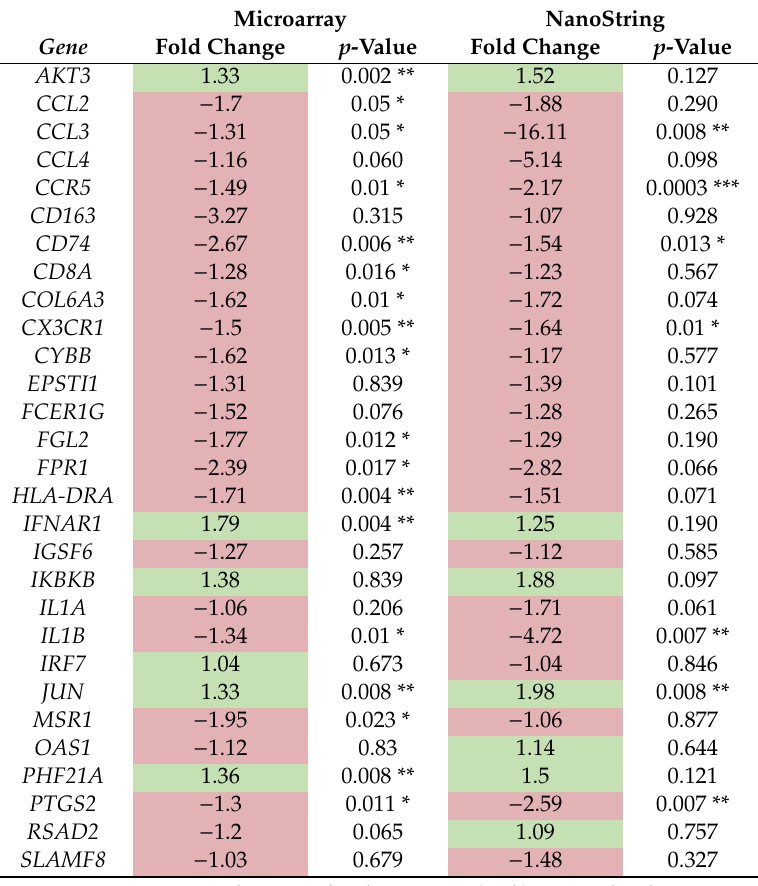
Table 6. Validation of candidate gene expression by NanoString